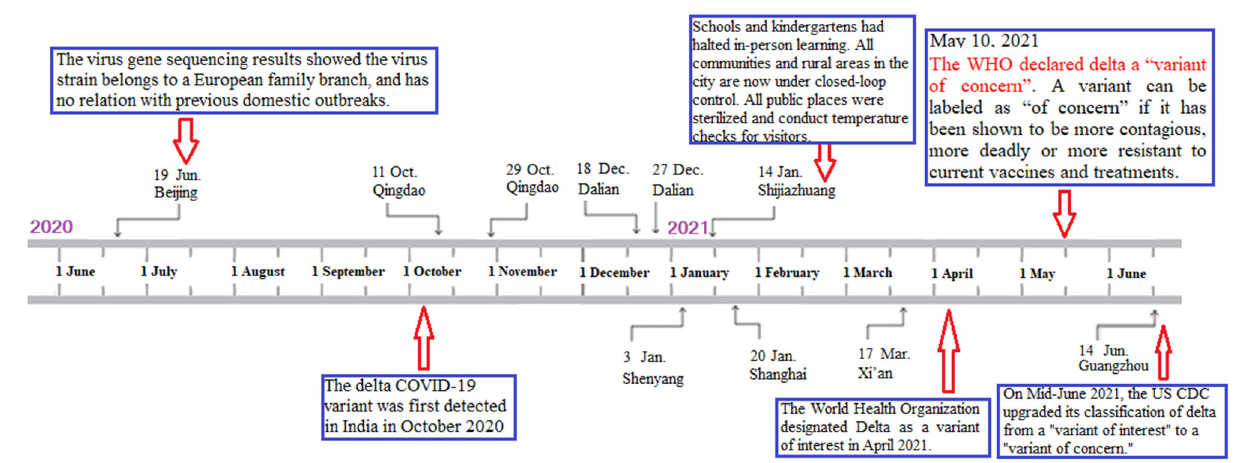
FIGURE 2 | The graph’s left-right axis is used as a timeline of the key events and dynamic profile of sporadic nosocomial COVID-19 infections from June 2020 to June 2021 in China. From June 2020 to June 2021, five cities in China had reported 10 series of cases with nosocomial COVID-19 infections, including 39 confirmed cases and 6 asymptomatic cases. The delta COVID-19 variant was first detected in India in October 2020. The World Health Organization designated Delta as a variant of interest in April and a variant of concern on 11 May 2021. In Mid-June 2021, the US Centers for Disease Control and Prevention upgraded its classification of the delta from a “variant of interest” to a “variant of